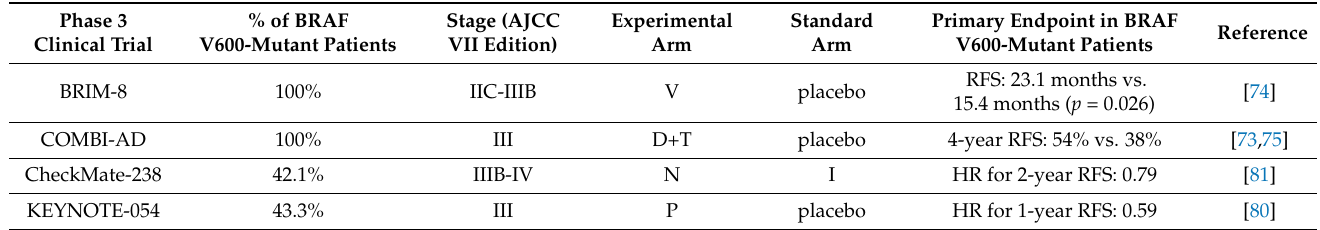
Table 3. Adjuvant Phase 3 clinical trials in BRAF V600-mutant high-risk resected melanoma patients. Phase 3 % of BRAF Clinical Trial V600-Mutant